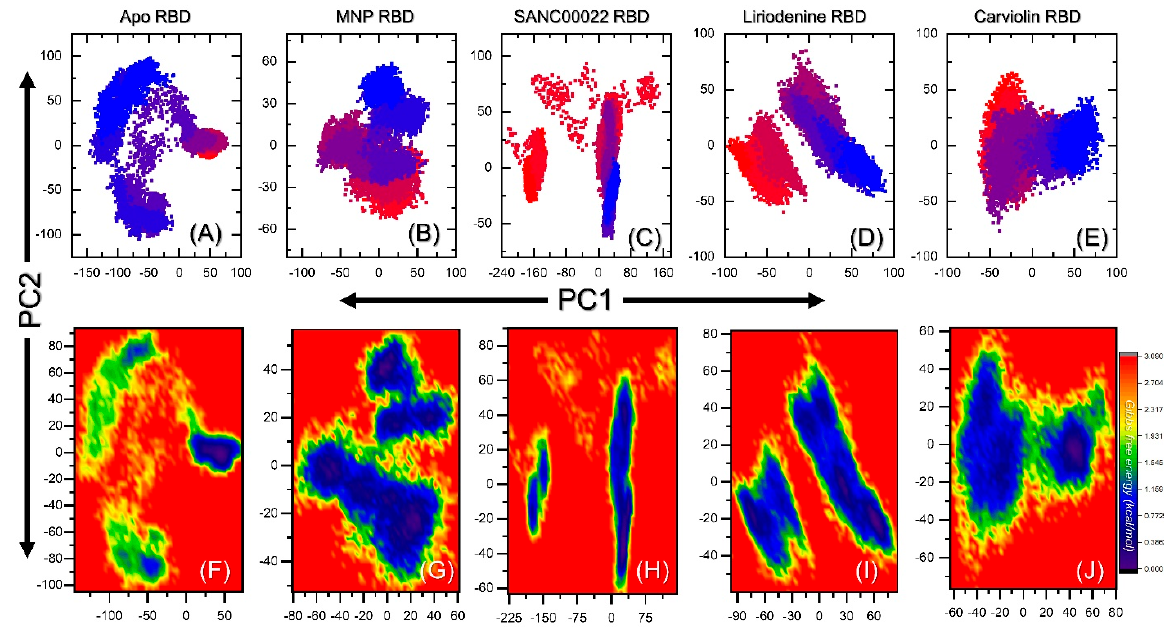
Figure 10. ( A – E ) Principal component analysis and ( F – J ) free energy landscape profiles of the hits.